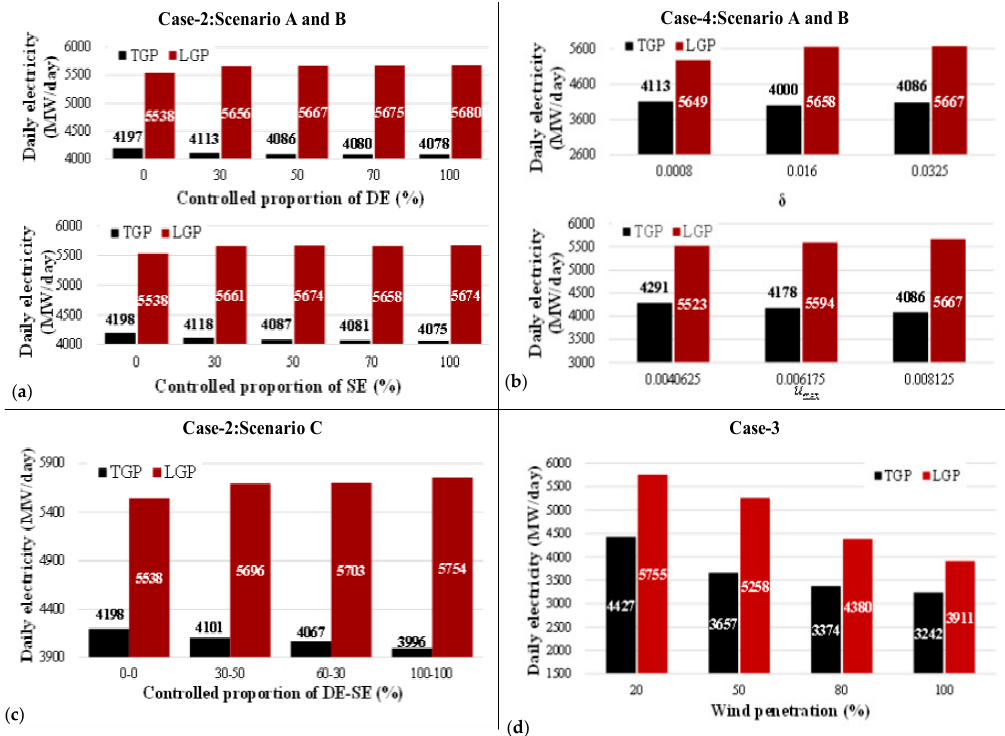
Figure 13. Daily electricity from the TGP and LGP for ( a ) Case-2, scenarios A and B; ( b ) Case-4, scenarios A and B; ( c ) Case-2, scenario C; and ( d ) Case-3.